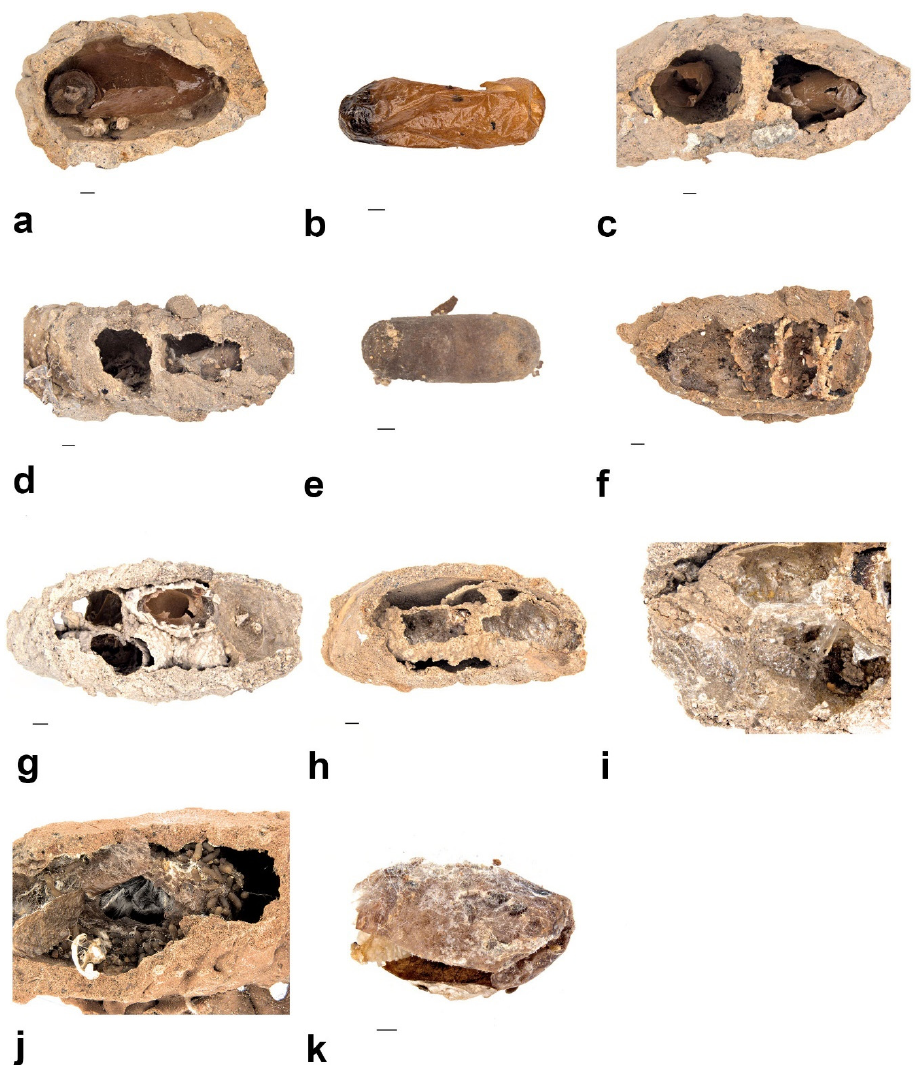
Figure 8. Nest structures and cocoon types of secondary tenants that nest inside mud nests of S. formosum : ( a ) Pison simillimum mud nest that contains the single cell and cocoon debris; ( b ) empty cocoon of Pison simillimum; ( c ) Pison simillimum mud nest that contains double cells and cocoon debris ( d , e ); nest of Pison spp. that produce hard cocoon; ( d ) Pison auriventre mud nest; ( e ) cocoon of Pison spinolae; ( f ) compartmentalized nests of Pison priscum with multiple cells lined up inside; ( g ) compartmentalized nests of Pison peletieri with ball-like nests built inside; ( h ) pipe-like nest of Paralastor sp. built inside; ( i ) nest of Hylaes nubilosus, with visible cellophane coatings that represents the genus Hylaeus; ( j ) nest of Megachile, with nearly emerged adult inside of the faeces-covered cocoon; ( k ) Brown cocoon and a dead larva of M. aurifrons . Scale bar = 1 mm.